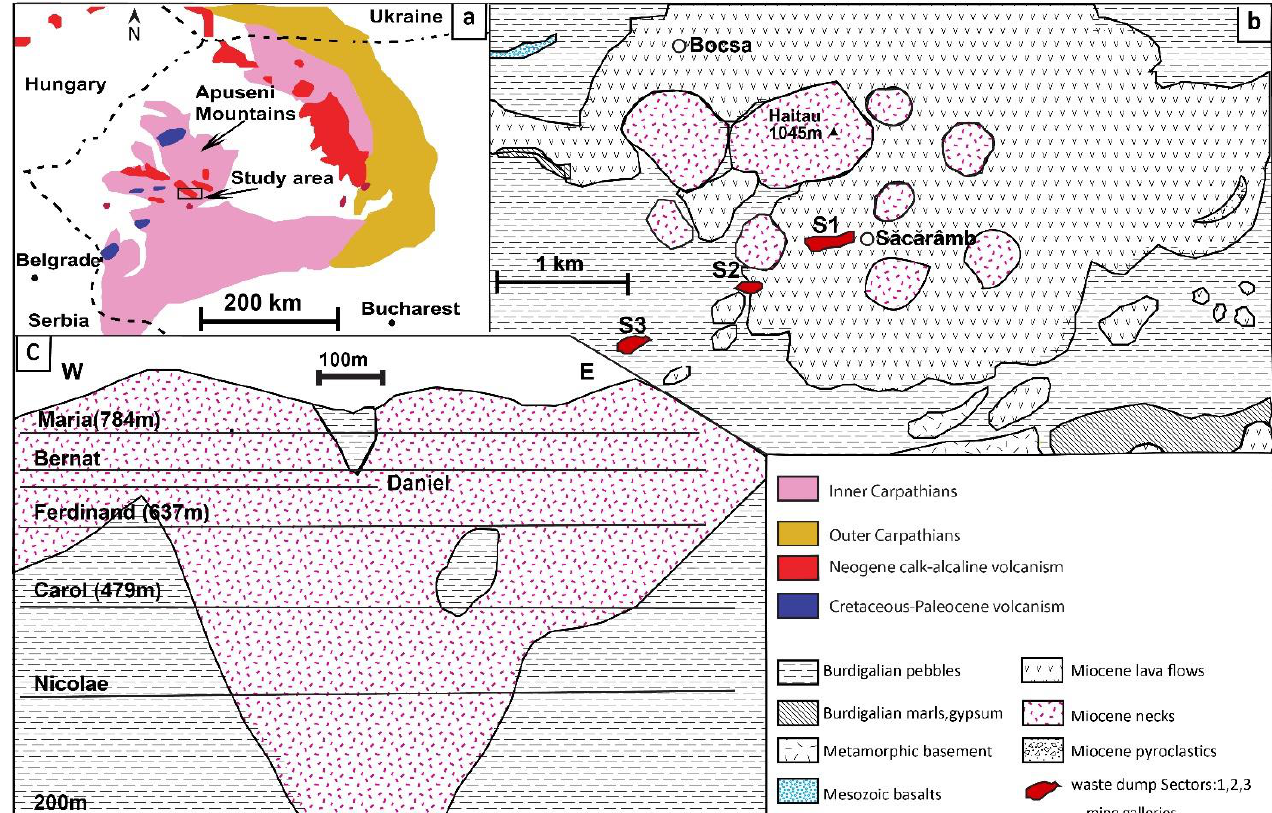
Figure 1. Localization of the studied area in the Carpathians ( a ); simplified geological map of Săcărâmb volcanic structure ( b ); simplified geologic cross- section through the Săcărâmb deposit ( c ), with the mining galleries redrawn after Uduba șa [18]; Alderton and Fallick [17].